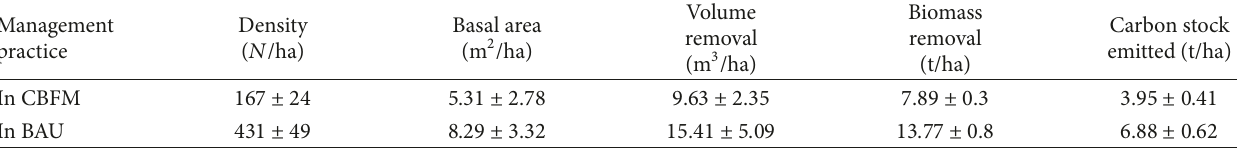
Table 5: Extent of woodland extraction and its corresponding emission in CBFM as compared to reference scenario ( 𝑛 = 244 ). Management